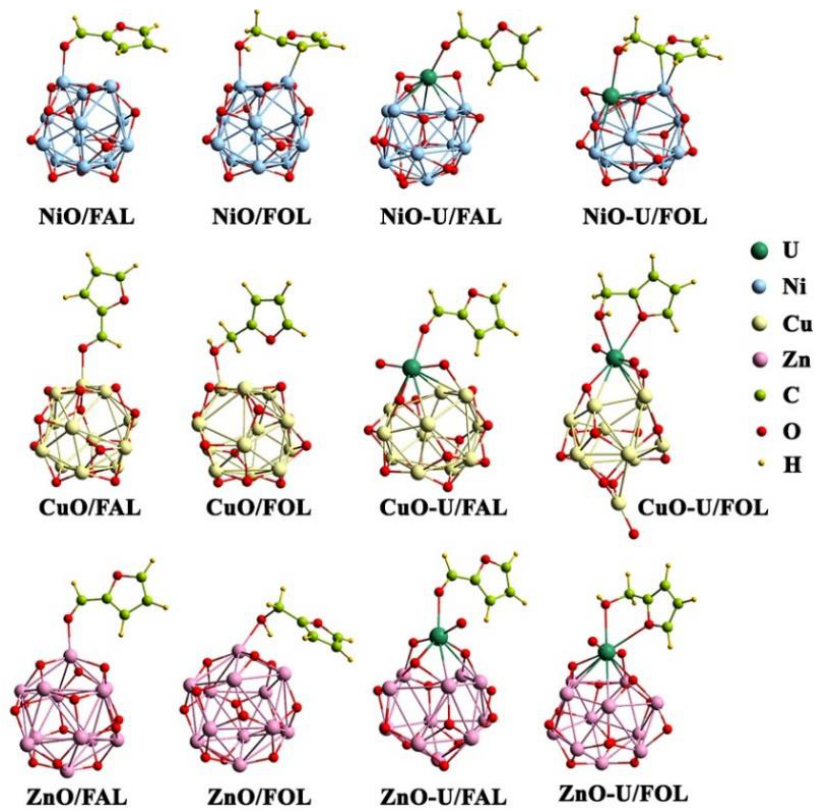
Figure 3. Optimized structures for intermediates Cat/FAL and Cat/FOL, where the most stable isomer for each intermediate is presented.